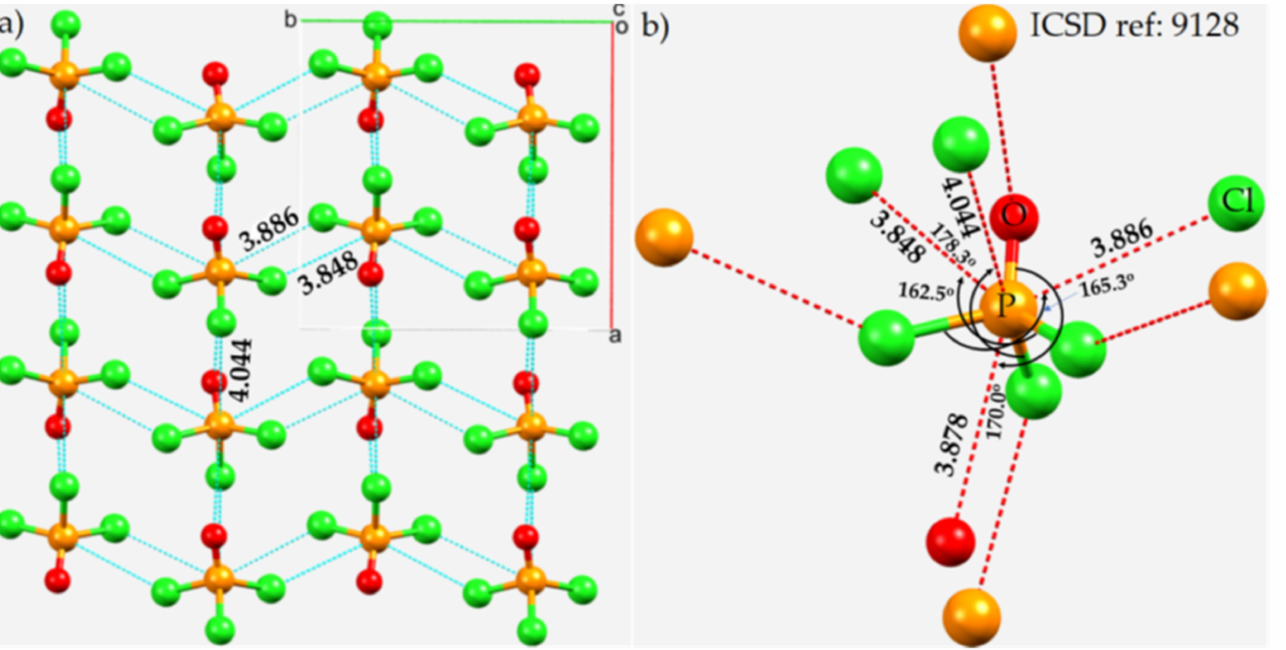
Figure 11. ( a ) The 2 × 2 × 2 supercell structure of the crystal of POCl 3 (space group: Pn2 1 a ), showing phosphorus-centered Type-II P ··· Cl pnictogen bonds. ( b ) The local topology of Type-II P ··· Cl and P ··· O pnictogen bonds formed along the extensions of the Cl–P and O=P covalent bonds in each POCl 3 molecule, respectively. Type-I and -II Cl ··· Cl contacts between the POCl 3 molecules in the crystal are not shown. Selected bond distances and angles are in Å and degrees, respectively. Atom type is shown in ( b ). Dotted lines between molecular entities in cyan represent intermolecular interactions, and the hanging contacts are represented by dotted lines in